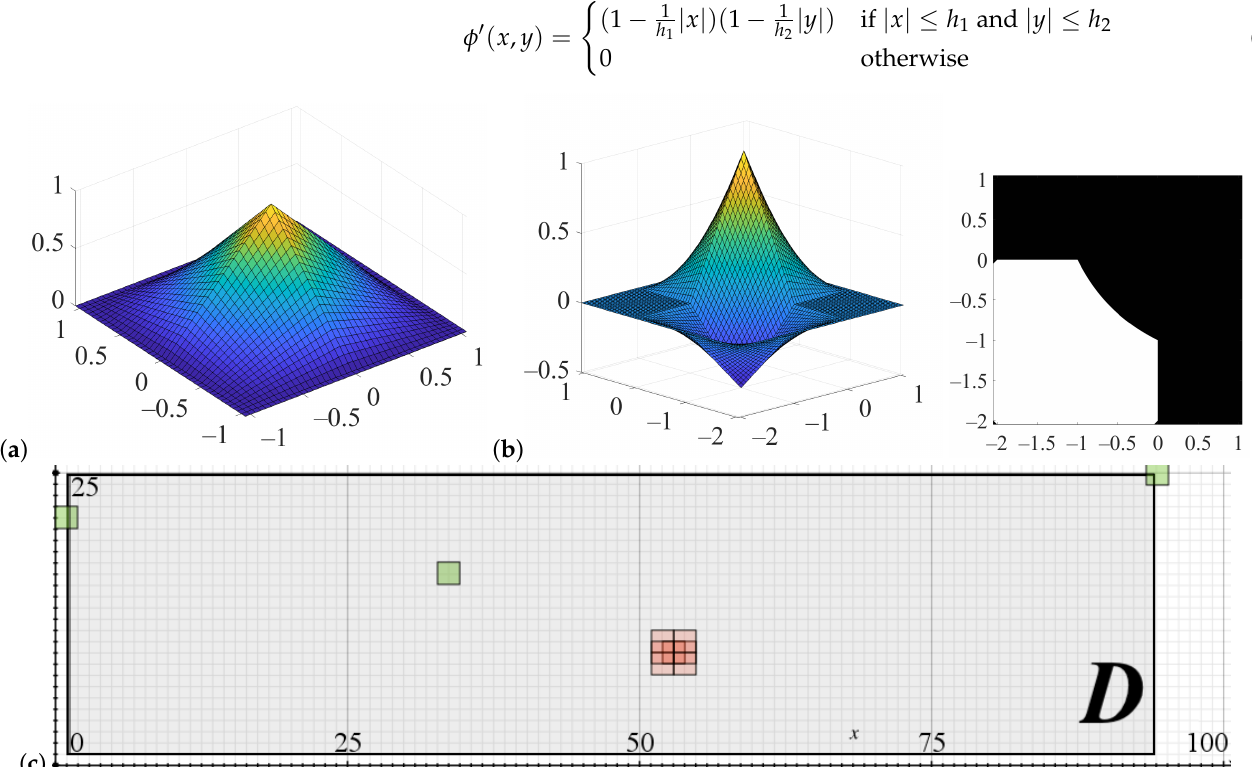
Figure 2. Bilinear spline construction: ( a ) the surface defined by the bilinear spline basis function (4); ( b ) the surface produced by two spline basis functions and its zero-level set (boundary); ( c ) rectangular domain D with 90 × 25 elements and 91 × 26